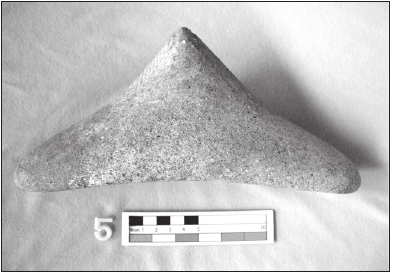
Figure 3. Three-pointer stone cemi (23.05cm wide, 9cm high) (No.